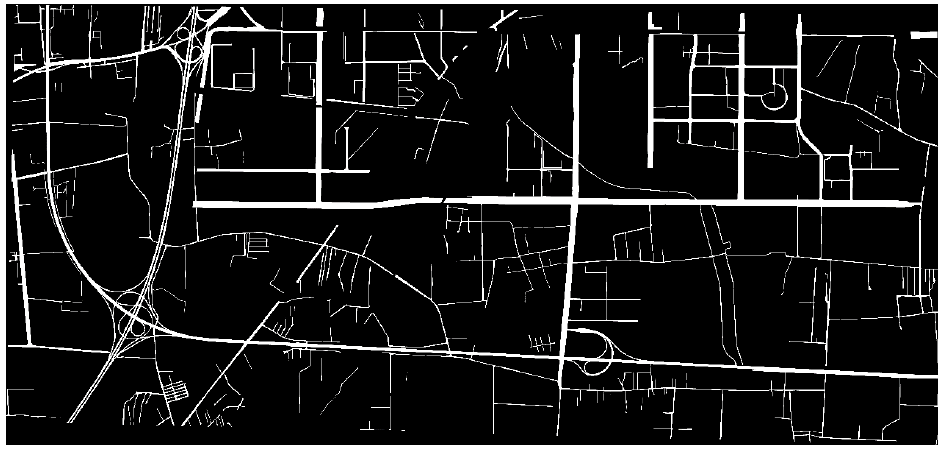
Figure 4. Label Result Image.